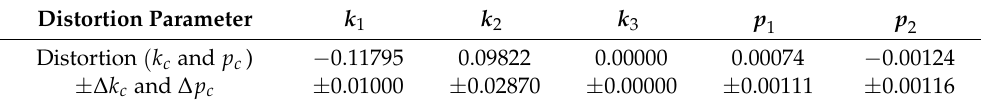
Table 2. Distortion parameters table.